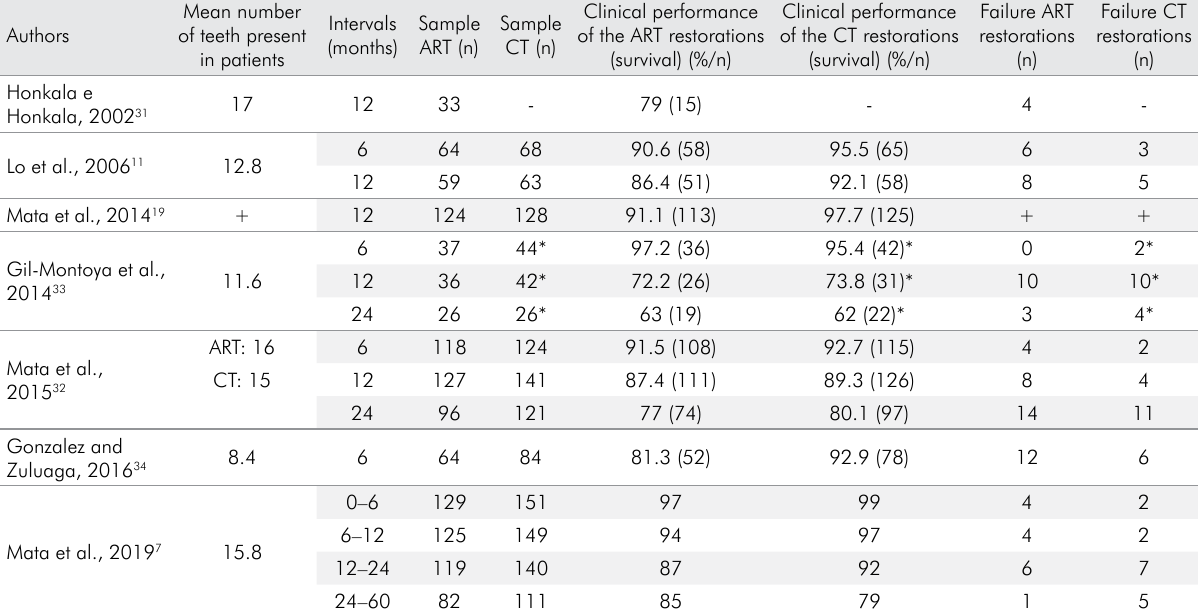
Table 4. Summary of the main results of the studies included in the qualitative analysis.